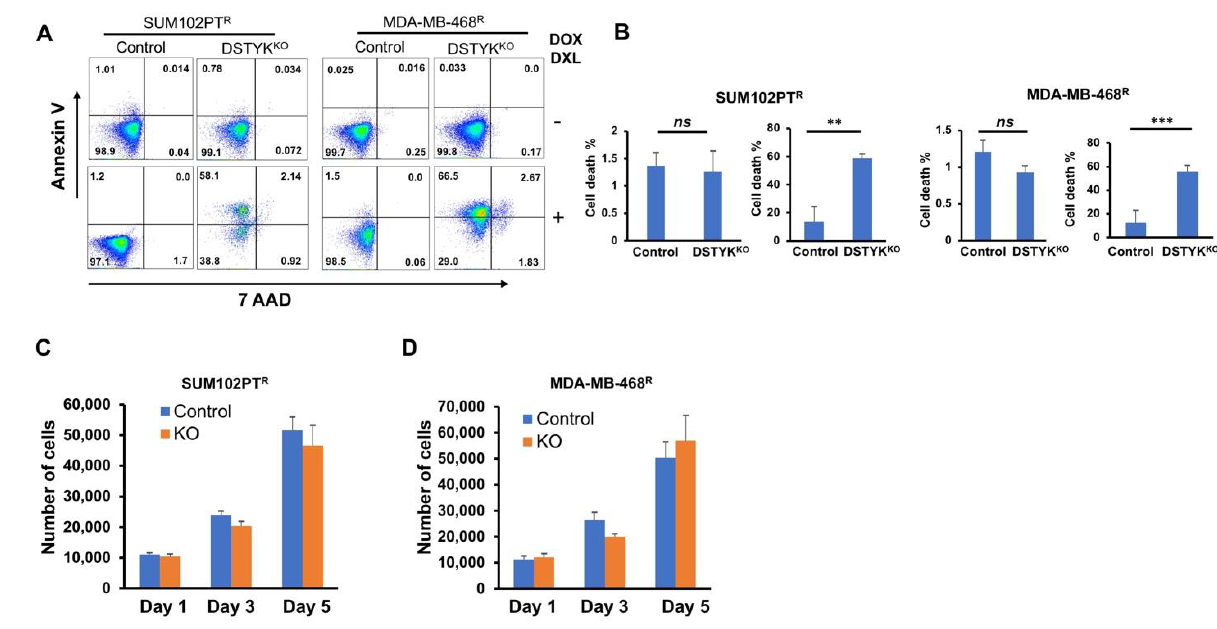
Figure 5. DSTYK KO sensitizes chemoresistant cells to chemotherapy drug treatment. ( A ) Representative images from flow cytometry analyses to compare the levels of cell surface apoptotic marker annexin V and the necrotic marker 7-ADD between control and DSTYK KO groups in SUM102PT R cells or MDA-MB-468 R cells with or without DOX/DXL. DOX/DXL 2 µ M/20 nm for SUM102PT R cells and 4 µ M/40 nm for MDA-MB-468 R cells. ( B ) The data in ( A ) are quantified. For each cell line, the left panel is the result for non-drug treated and the right panel is the result for drug-treated. The data represents mean values ± SD; ns , not significant; ** p < 0.01; *** p < 0.001. ( C , D ) DSTYK KO resistant cell growth for 5 days and total numbers of cells were counted on days 1, 3, and 5 ( n = 3 independent experiments) in SUM102PT R cells and MDA-MB-468 R cells.